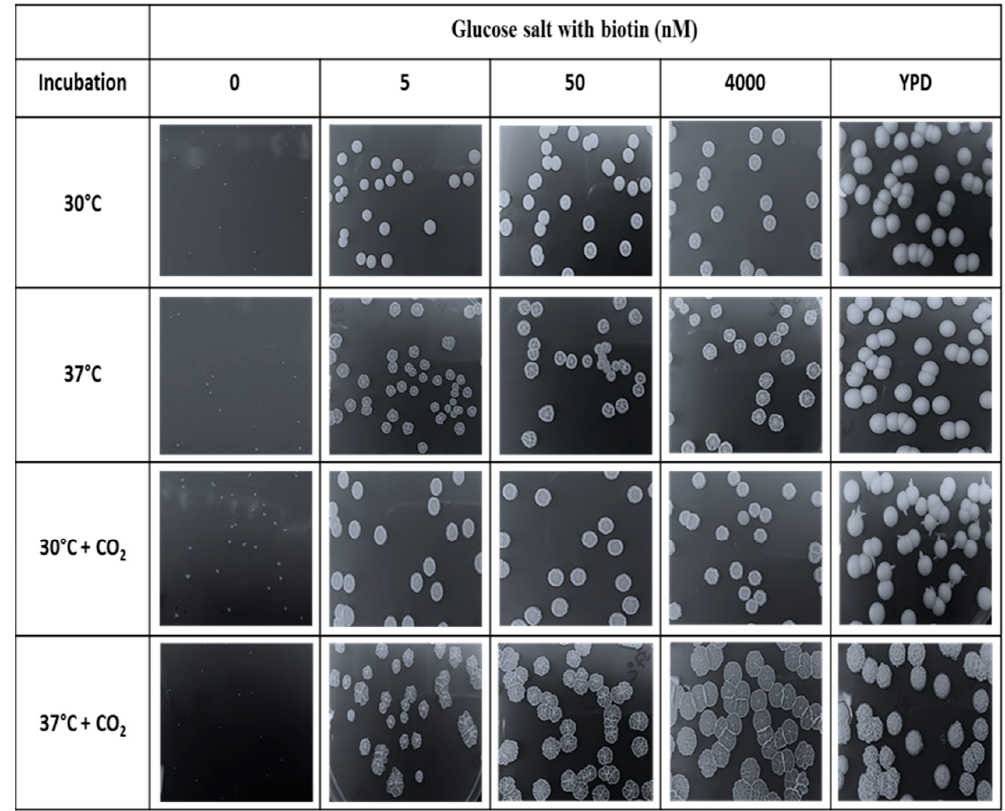
Figure 9. Colony morphology for C. albicans grown in YPD 2% agar or glucose-salts 2% Noble agar with 0, 5, 50, or 4000 nM biotin after 5 days incubation period at 30 °C or 37 °C with or without 5% CO 2 . Different magnifications were used to show colony morphologies. Noted that colony sizes were mentioned in Table 4.